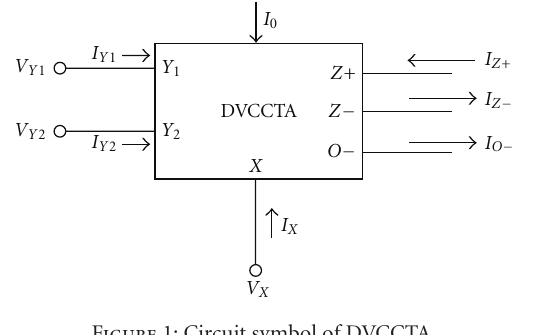
Figure 1: Circuit symbol of DVCCTA.